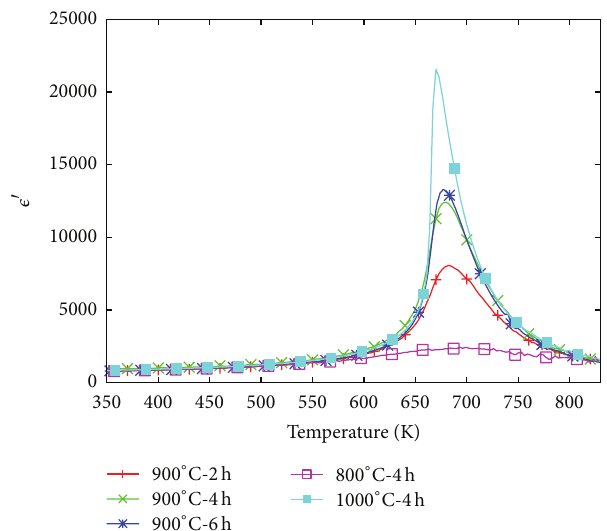
Figure 4: Real part of the dielectric constant ( 𝜖 󸀠 ) measured at 1kHz from RT to 530 ∘ C of PYN-PT 60% ceramic obtained from various sintering temperatures and